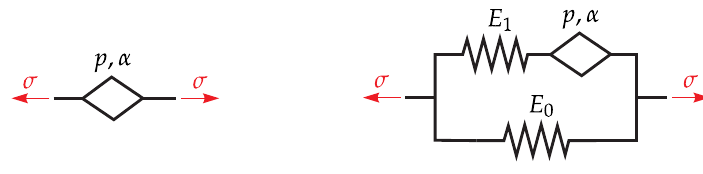
Figure 4. Springpot ( left ) and fractional Zener model ( right